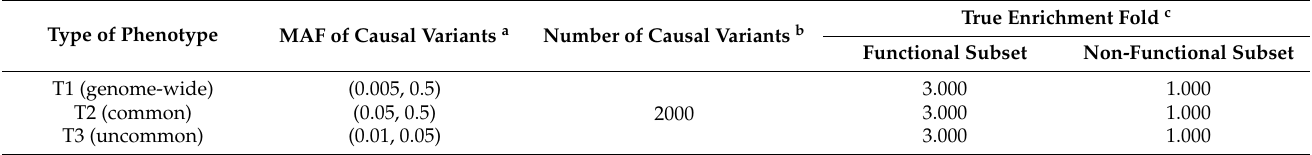
Table 1. The attributes for each type of simulated